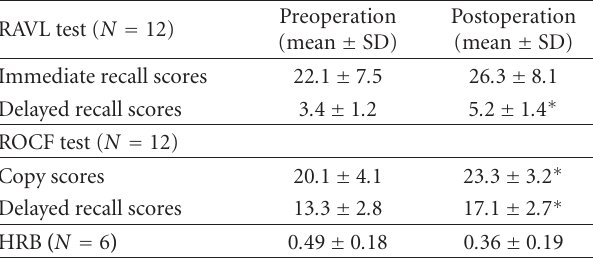
Table 3: Pre- and postoperative intellectual assessment scores.